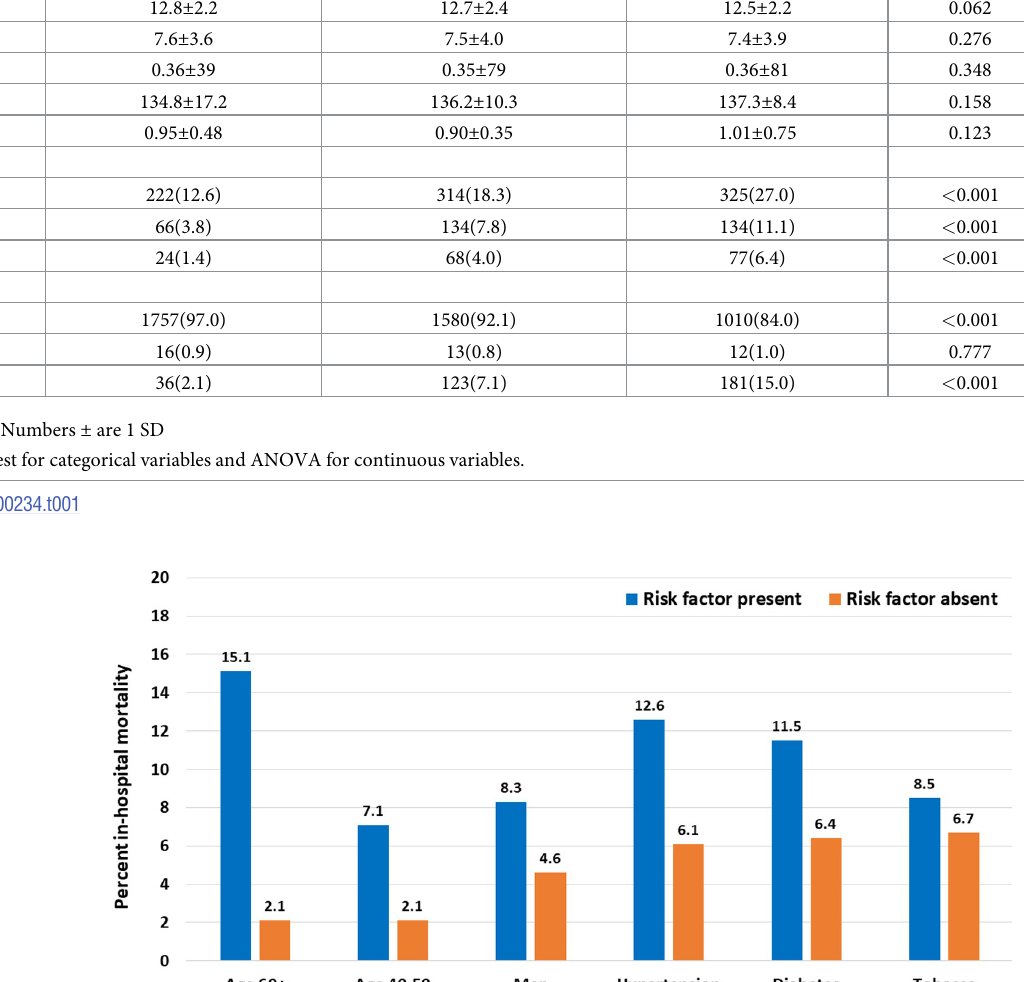
Fig 2. In-hospital deaths in COVID-19 patients with or without the risk